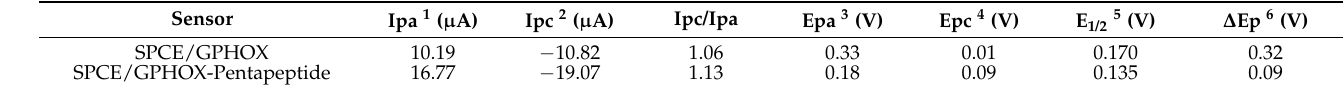
Table 1. The values of the parameters obtained from the CVs of the two sensors immersed in 10 − 3 M K 4 [Fe(CN) 6 ]/K 3 [Fe(CN) 6 ] solution (the electrolyte support was 0.1 M PBS of pH 6.5).